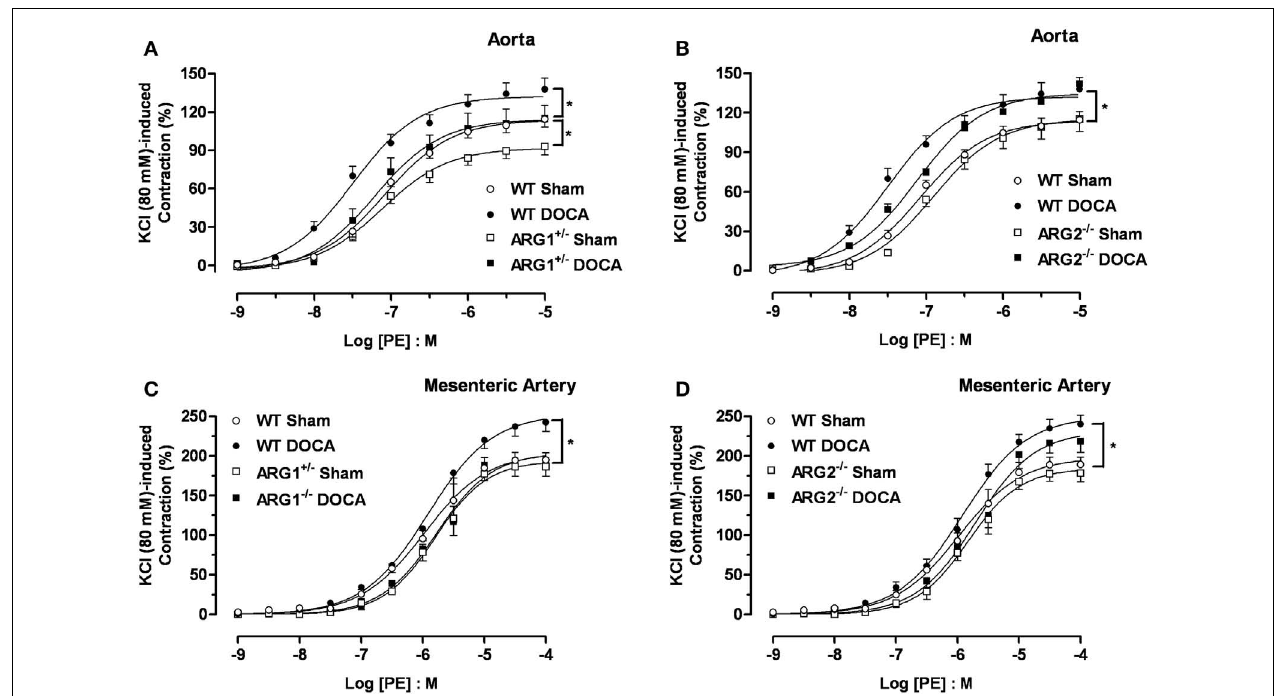
arginase 2 (ARG2 − / − ) uninephrectomized (ARG2 − / − Sham) and ARG2 − / − DOCA-salt treated mice in aorta (A,B) , and mesenteric artery [MA; (C,D) ]. Experimental values were calculated relative to the maximal changes from the contraction produced by KCl (80mM), which was taken as 100%. Data represents mean ± SEM of five experiments. * P < 0.05, compared with WT Sham